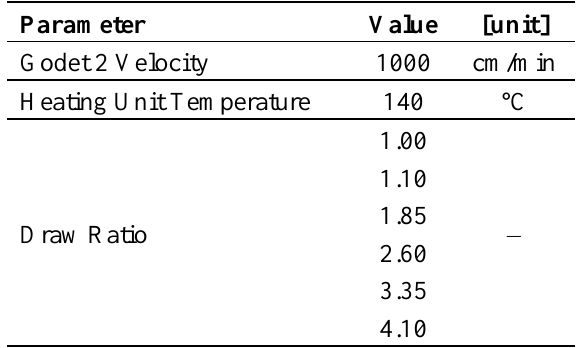
Table 3. Parameters for applying different draw